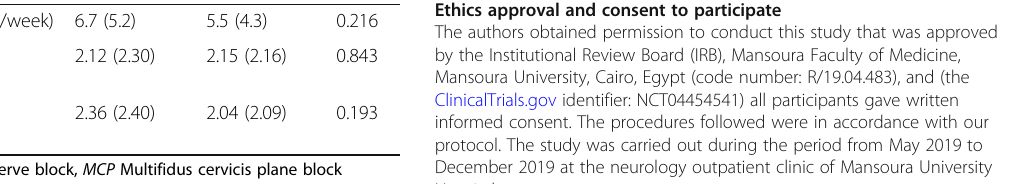
Table 3 Headache frequency (secondary outcome) GONB group MCPB group P